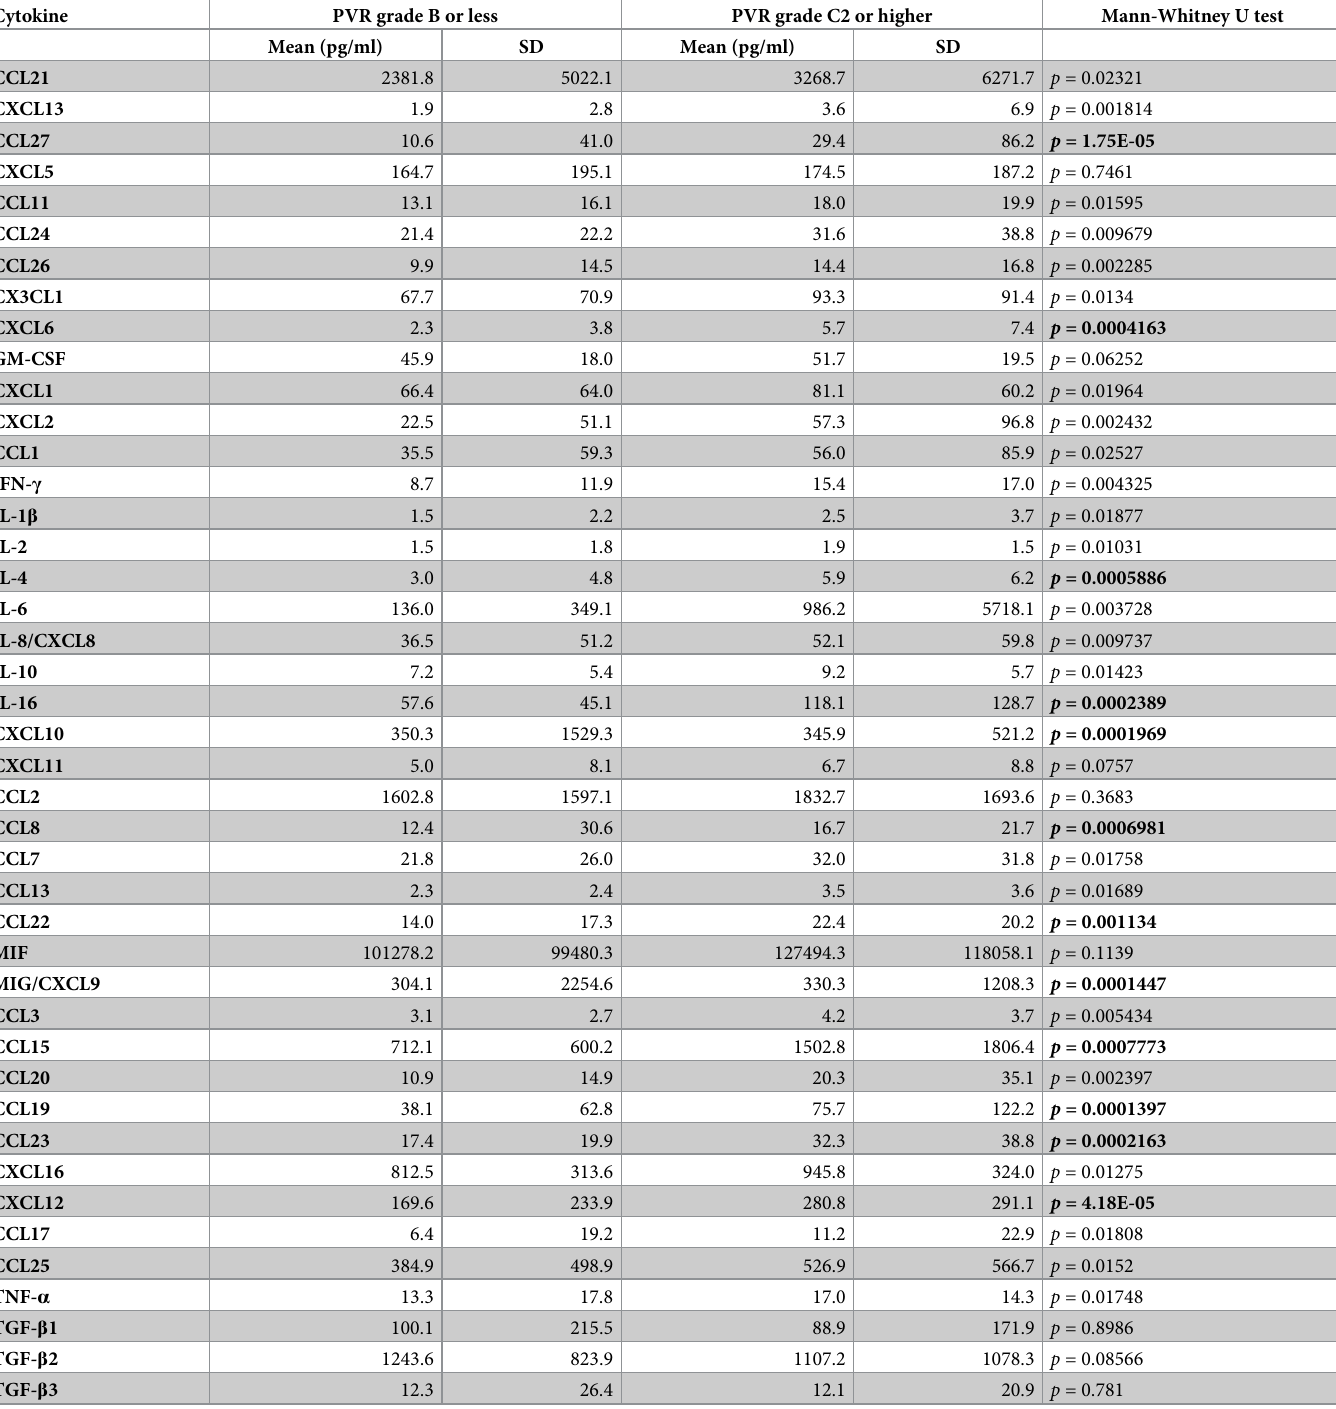
Table 5. Mean concentrations (pg/ml) and standard deviations (SD) of cytokines in the vitreous of eyes with primary retinal detachment with PVR grade B or less and in eyes with primary retinal detachment and PVR C2-D.